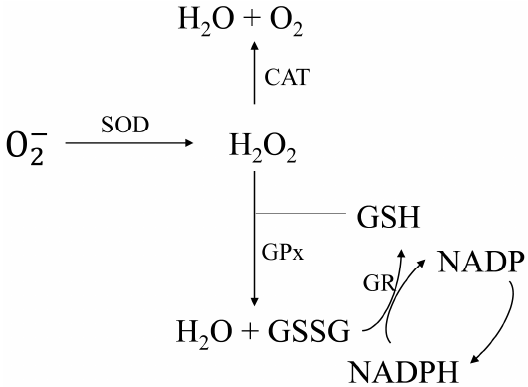
Figure 1. The antioxidant system in filamentous fungi. catalase, CAT; superoxide dismutase, SOD; glutathione peroxidase, GPx; glutathione reductase, GR; reduced glutathione, GSH.